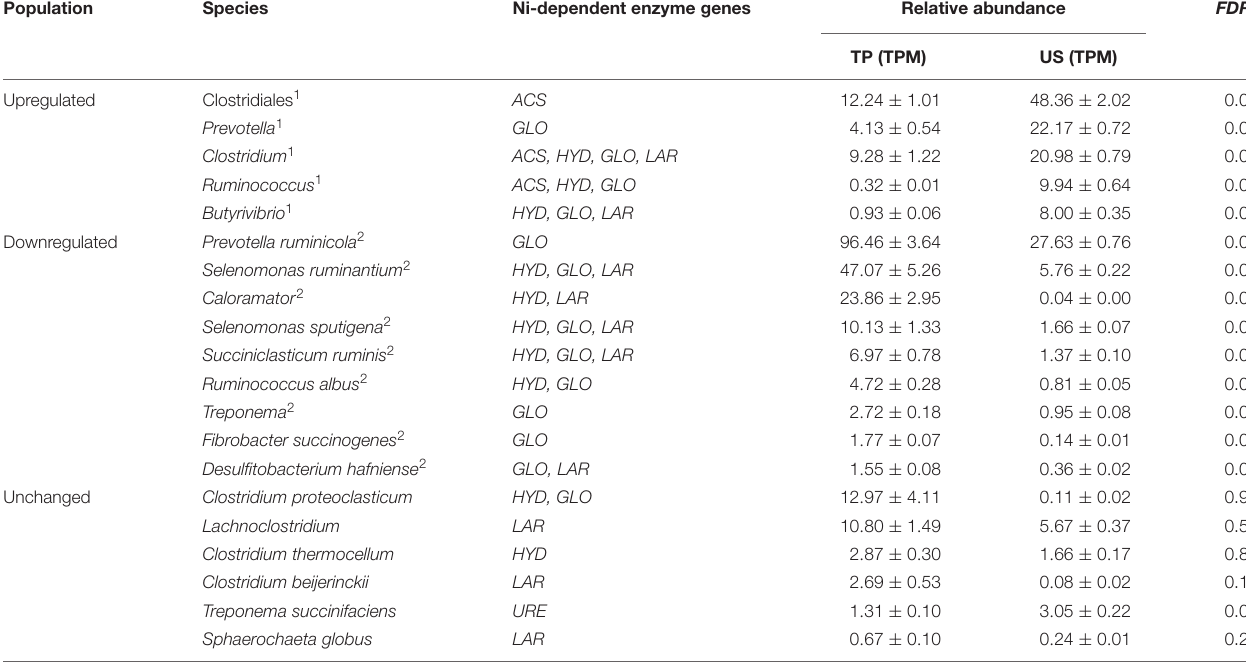
TABLE 4 | Comparison of the relative abundances and the compositions of Ni-dependent enzyme genes of the 20 Ni-dependent bacteria. Population